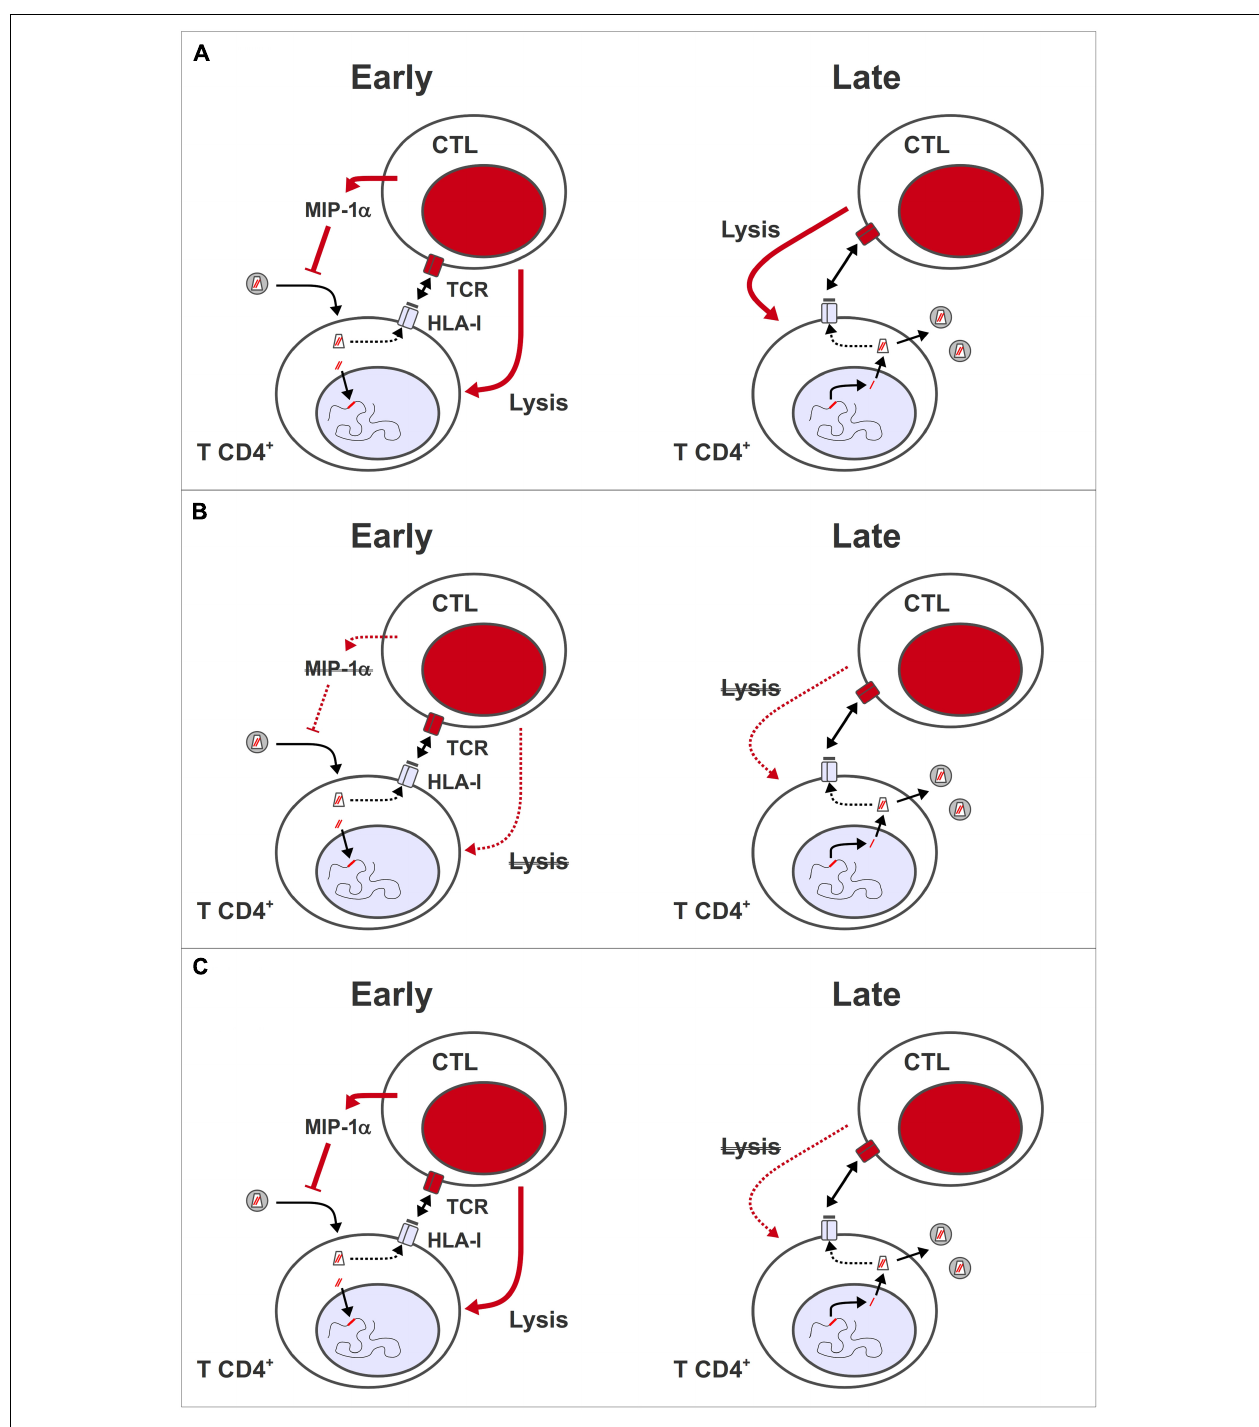
FIGURE 1 |Antiviral activity of HIV-specific CTL during early and late phases of virus replication. (A) During the pre-integration stages of HIV replication, virus-specific CD8 + T lymphocytes can inhibit viral replication through the release of soluble mediators, such as MIP-1 α , which blocks virus entry, and/or by lysing infected cells presenting peptides derived from incoming capsid antigens. During the post-integration stages, virus-specific CD8 + T lymphocytes lyse cells expressing viral genes from integrated provirus, thus reducing the number of progeny virions that are released per